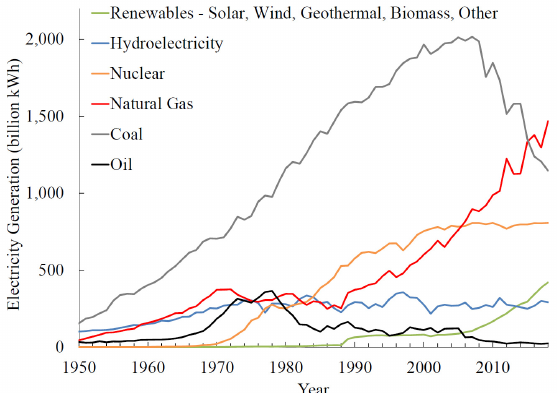
Figure 9. United States electricity generation by source, from 1950 to 2018, given in units of billion kilowatt ‐ hour. Renewables include solar, wind, geothermal, biomass and waste. Data are from U.S. Energy Information Administration